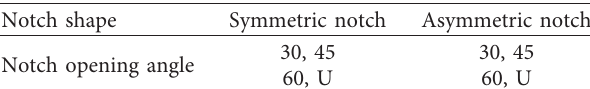
Figure 1: Geometry of (a) finite element model and (b) notch specimen. Table 3: The types of notch opening